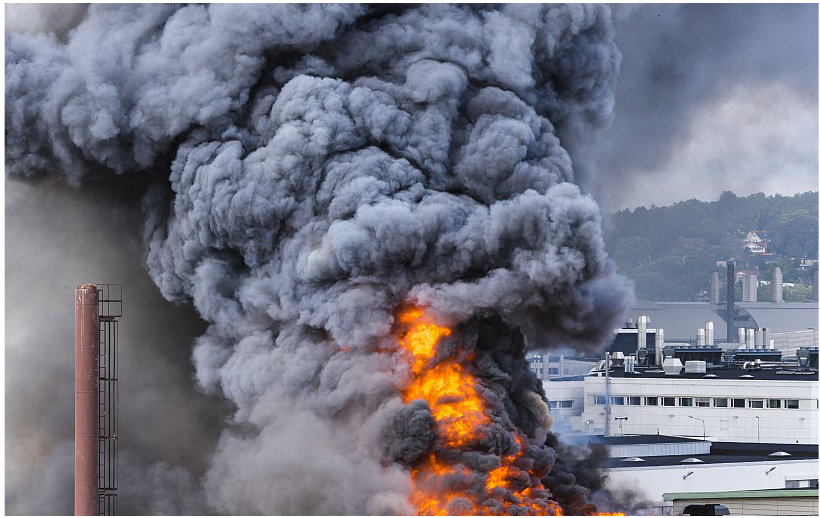
Figure 6. Emergency rescue teams: rescue teams in Jilin Province (picture source: [21]).